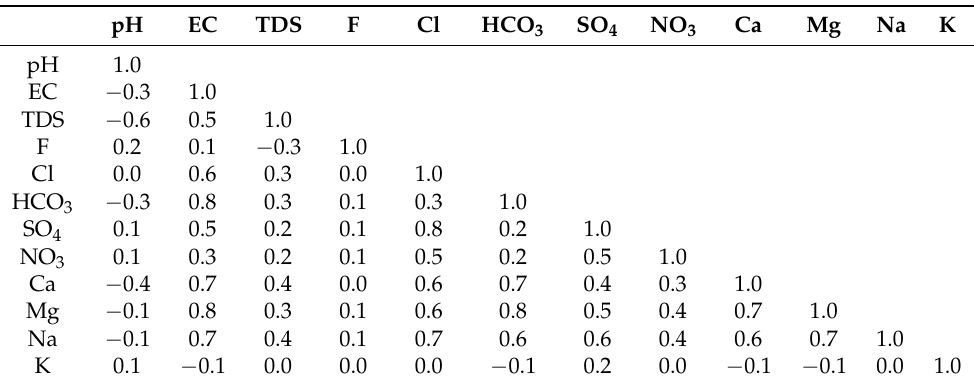
Table 2. Inter-elemental correlation matrix of major